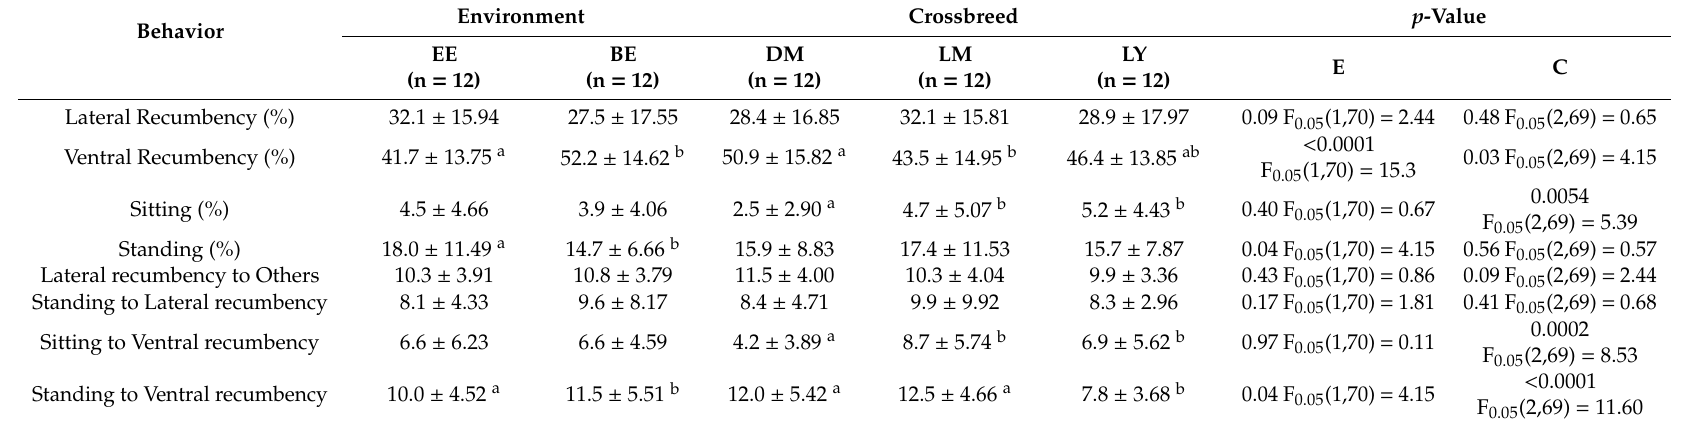
Table 4. Maternal behavior of sows from weeks 2 to 5 postpartum.